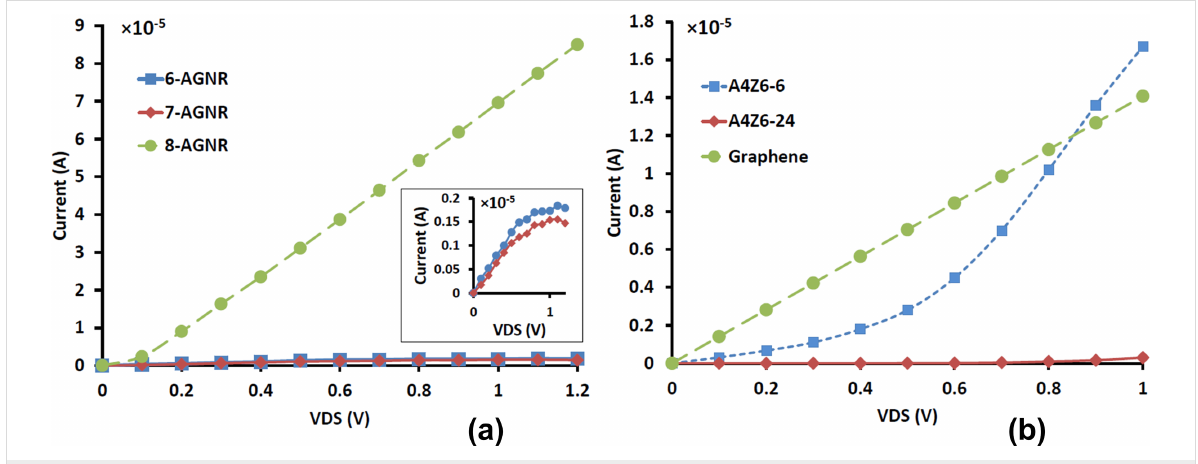
Figure 4: Current–voltage ( I – V ) characteristics of (a) different GNR devices and (b) GNM and graphene devices.